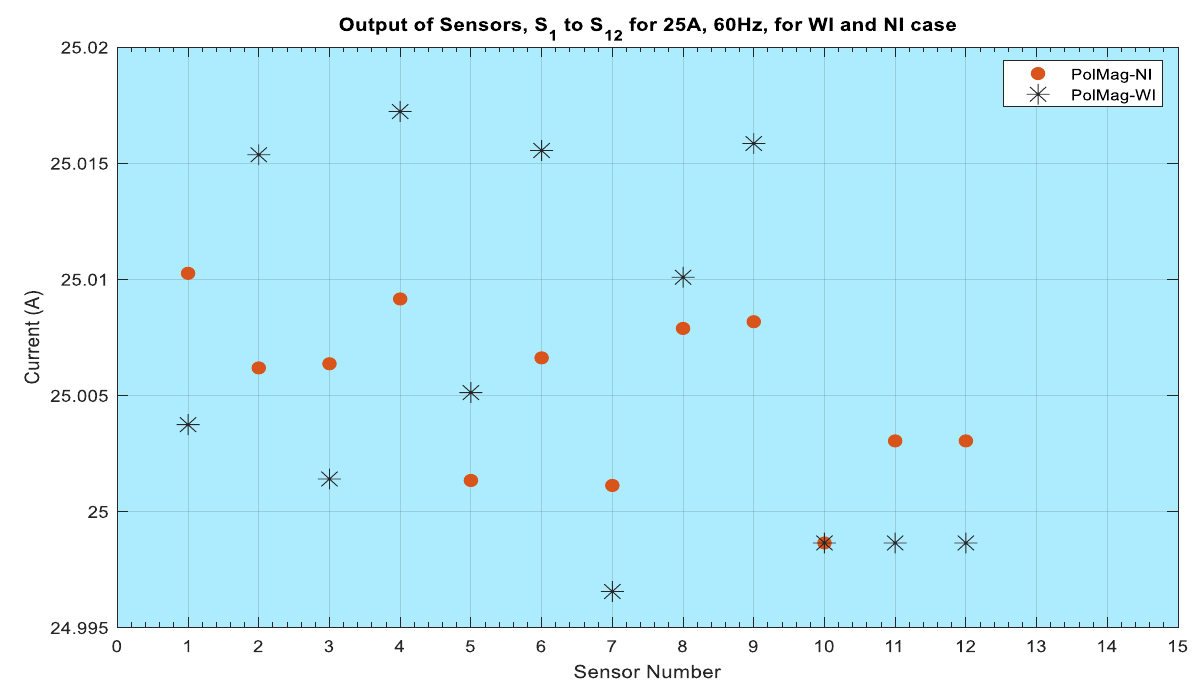
Figure 17. Output of all sensors for 25 A, 7 mm, 60 Hz: WI and NI